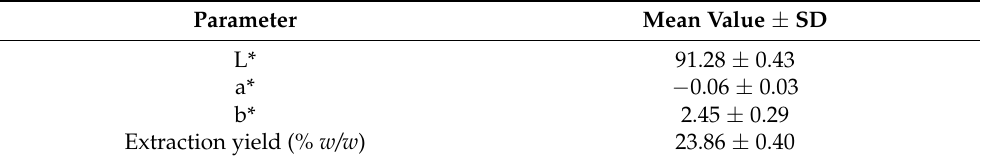
Table 5. Color parameters and extraction yield of Ceiba aesculifolia subsp. parvifolia tuber starch.